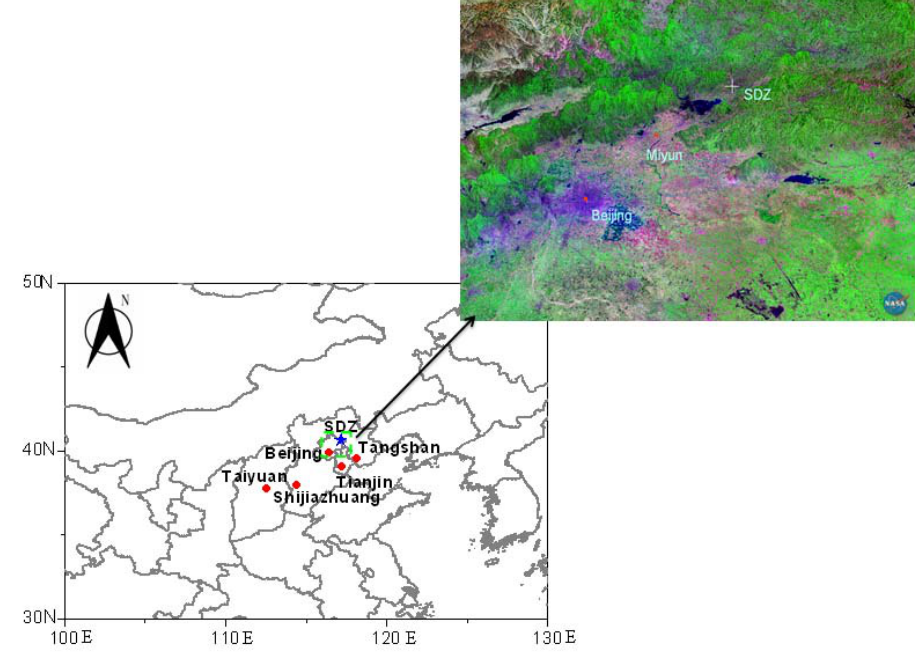
Fig. 1. Location of the SDZ station (blue star) and the main cities in Northern China (red dots) in the lower left panel. The upper right panel shows the topography and land use in the surrounding area (covered by green box), the white cross indicating SDZ station and red dots indicating Miyun county and Beijing, respectively. Green, blue and purple indicate mountains regions, river and residential areas, respectively. NLT landsat7 pseudo color map is from http://worldwind.arc.nasa.gov. Vertical exaggeration is by a factor of 3.